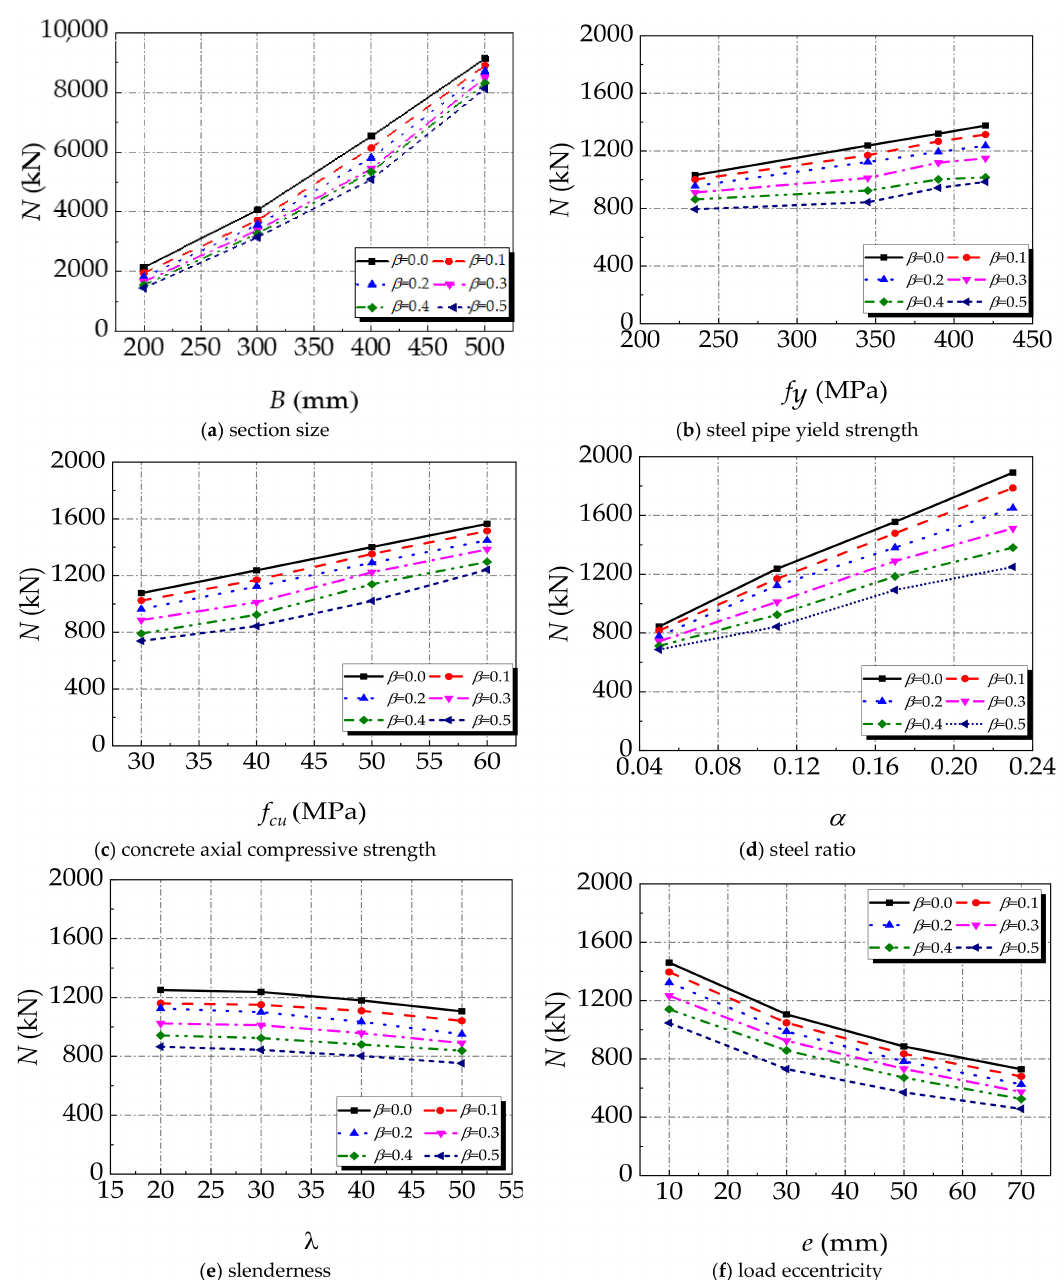
Figure 9. The influence of different parameters on the ultimate bearing capacity of specimens ( a ) section size; ( b ) steel pipe yield strength; ( c ) concrete axial compressive strength; ( d ) steel ratio; ( e ) slenderness; ( f ) load